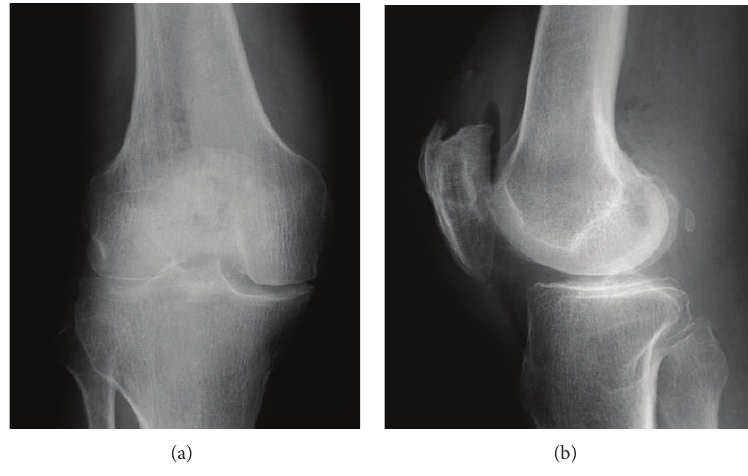
Figure 6: Plain radiographs after surgery to remove all